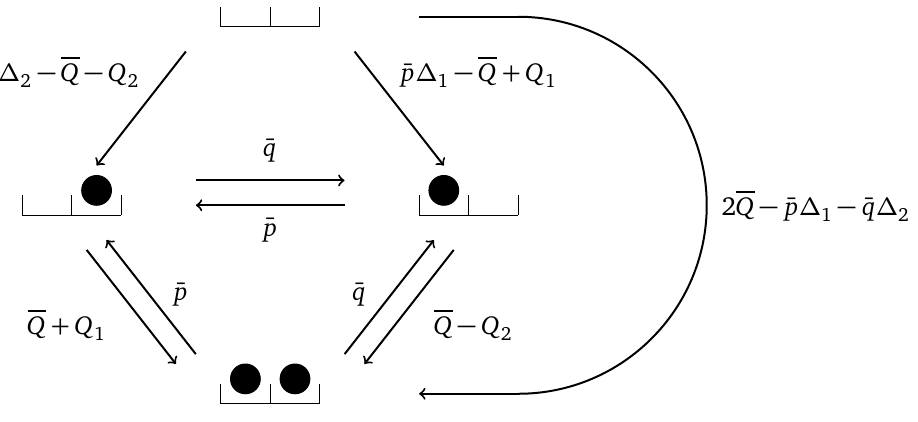
Figure 2: Non vanishing rates between the different configurations at the impurity junction. The left site on the figure corresponds to the site L